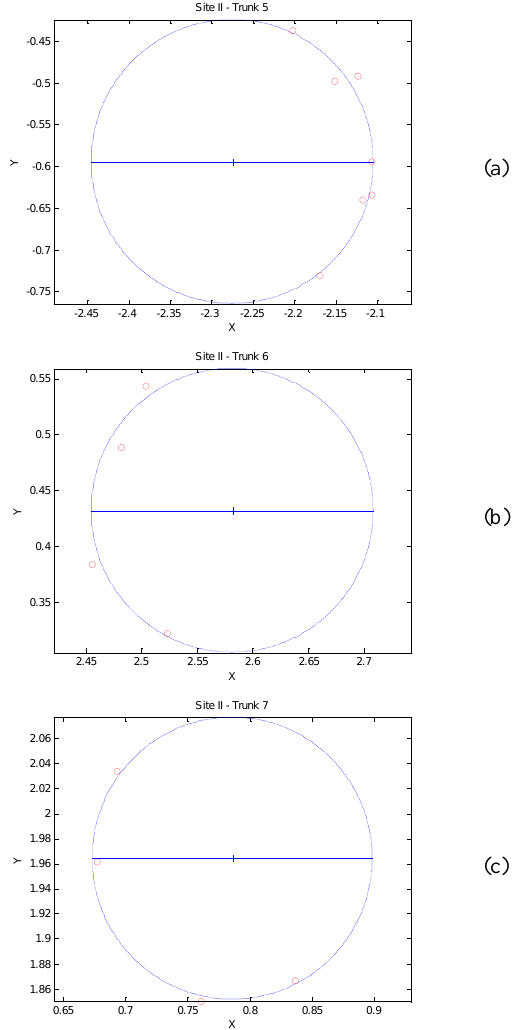
Figure 7. Circle fitted to the XY coordinates (small red circles) of points on the trunk surface.